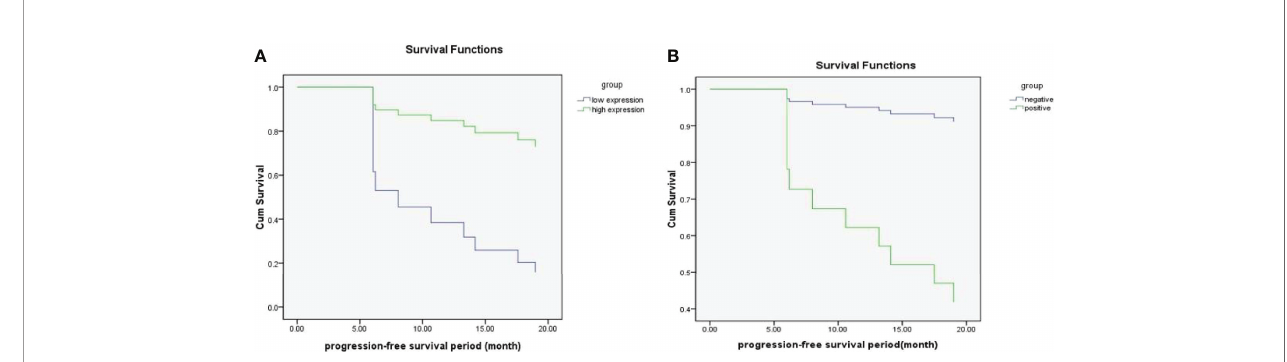
FIGURE 3 | (A, B) The survival functions for Ki67 PI low-expression group and high-expression group (A) ; The survival functions for positive group and negative group (whether peritoneal implantation metastasis was present)